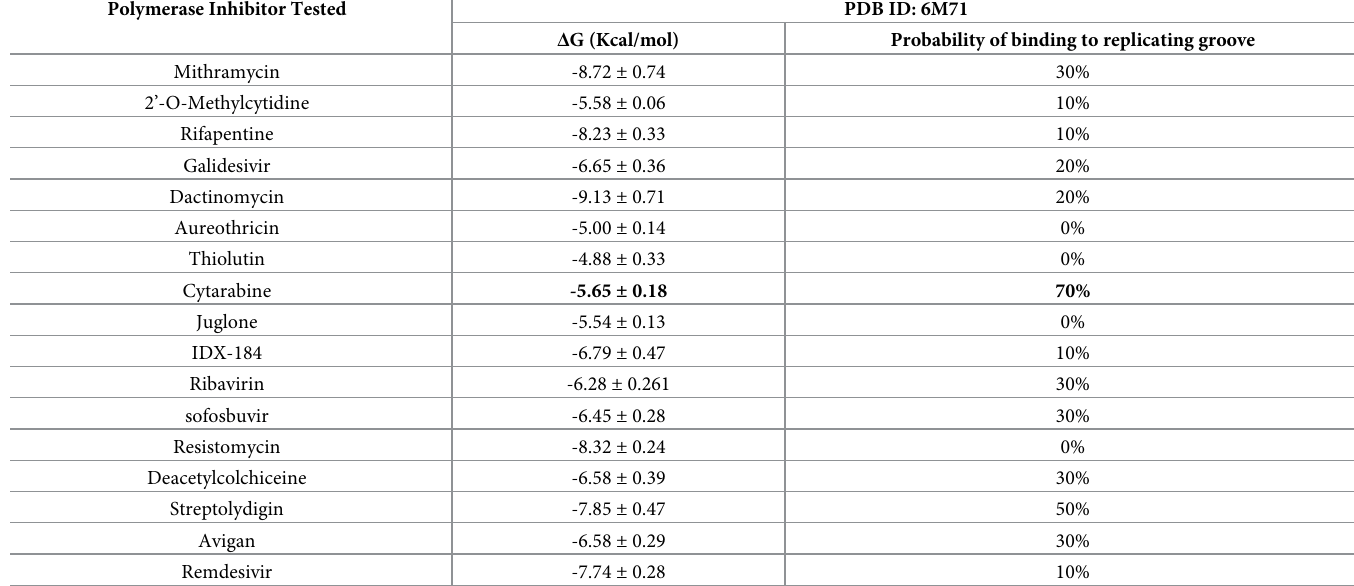
Table 1. List of the molecular docking scores in Kcal/mol calculated using AutoDock Vina against SARS-CoV-2 (PDB ID: 6M71, nsp12-nsp8-nsp7). The docking procedure was done ten times for each ligand, and the likelihood of binding to the replicating groove were determined. The highest probabilities of binding to PDB ID: 6M71 are shown in bold red color.